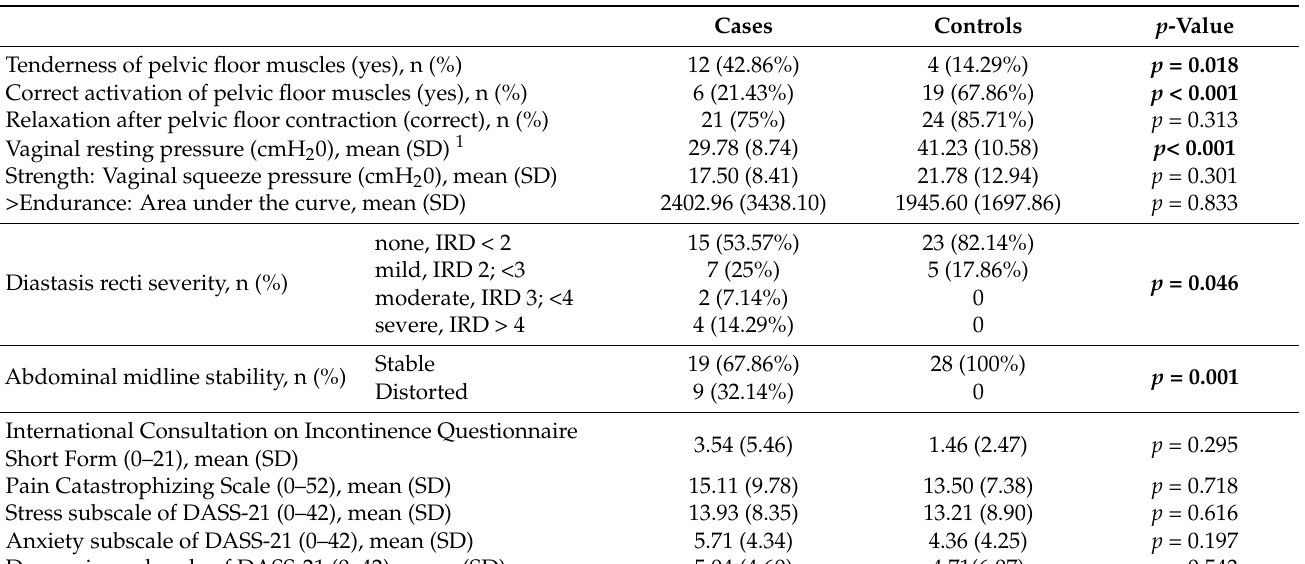
Table 3. Differences between cases with pelvic girdle pain (n = 28) and the controls (n = 28) with respect to the measured